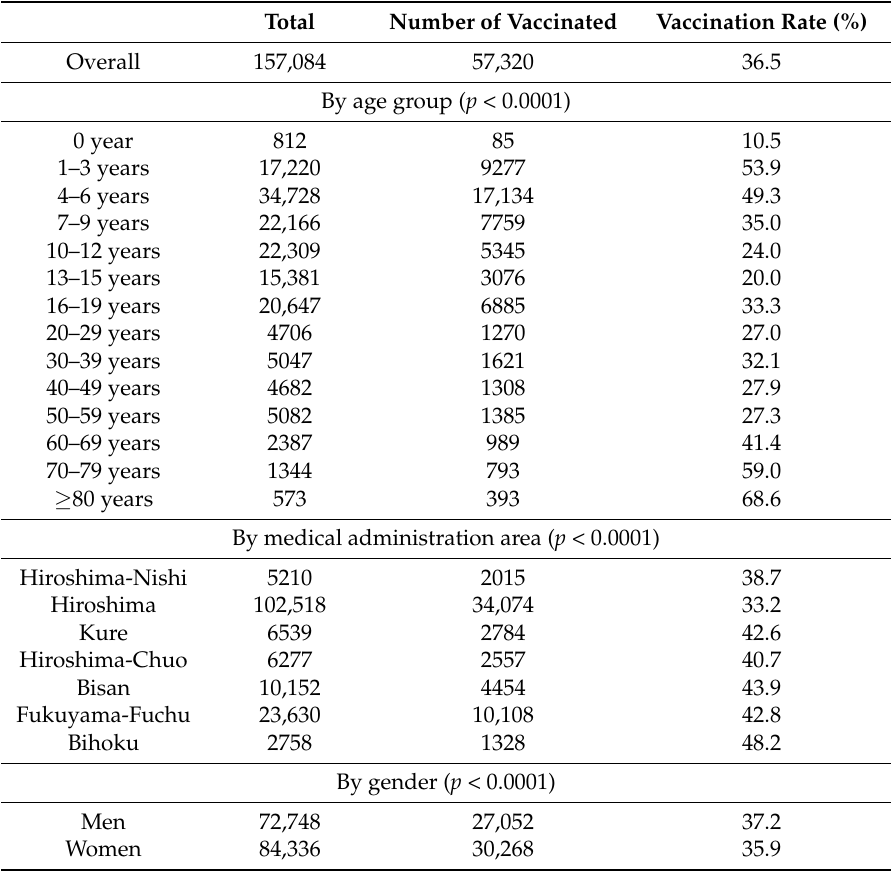
Table 2. Vaccination